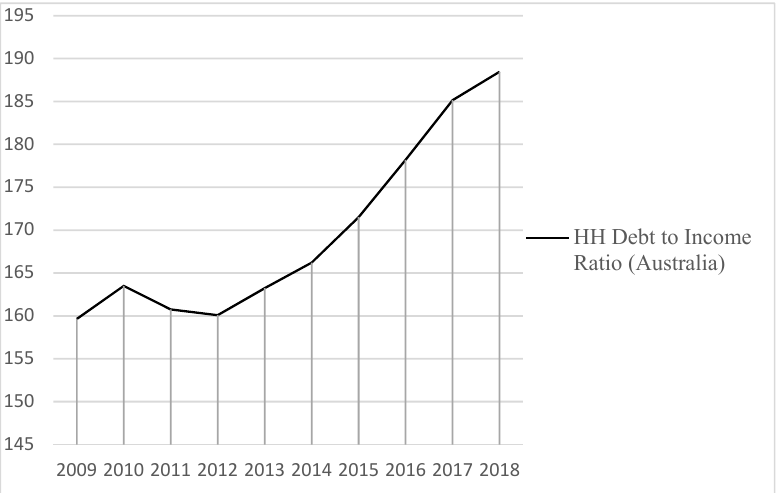
Figure 1. Household debt to income ratio of Australians from 2009 to 2018 . Data of the figure is adapted from the Reserve Bank of Australia (2019).